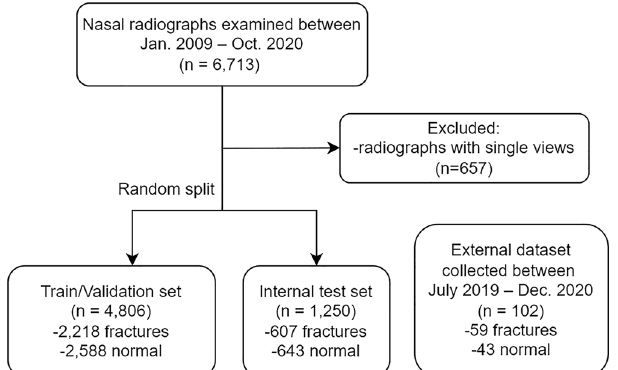
Figure 4. A flowchart of patient selection